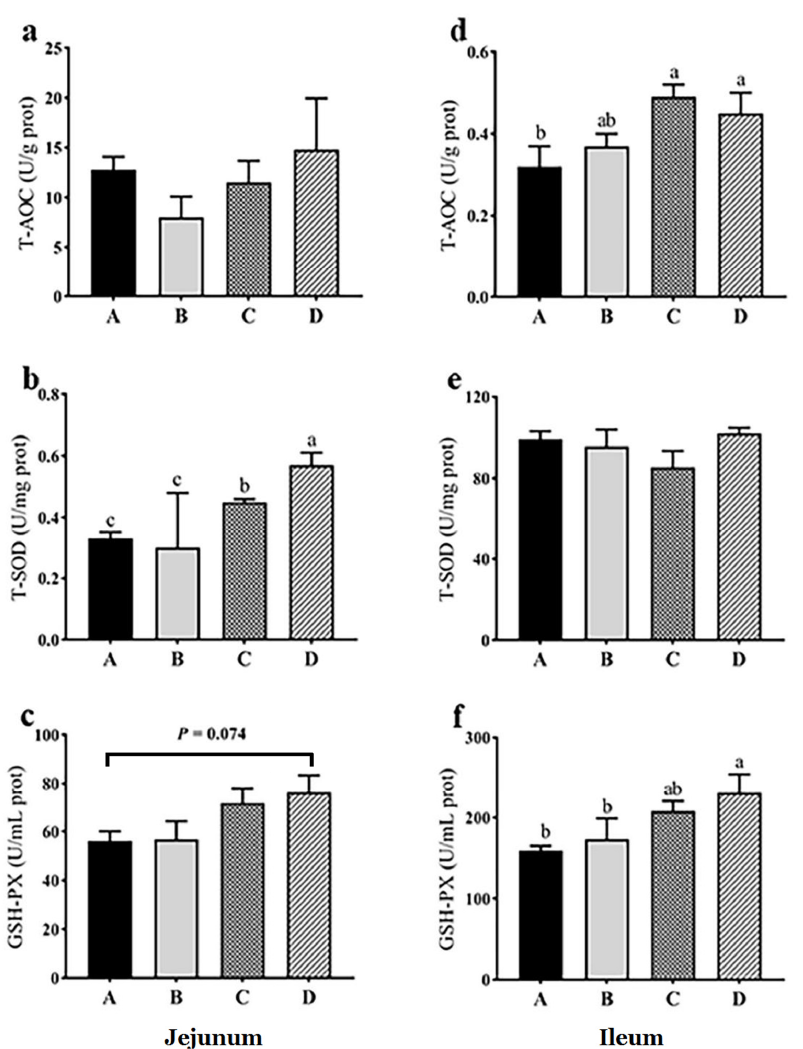
Figure 1. Effects of dietary probiotics on jejunal ( a – c ) and ileal ( d – f ) antioxidant capacities of geese at the age of 70 days. Note: a and d for total antioxidative capacity (T-AOC), b and e for total activity of superoxide dismutase (T-SOD), c and f for the activity of glutathione peroxidase (GSH-PX). Group A (as control) was fed a basal diet, the treatment groups (B, C and D) were fed the basal diet supplemented with 250 mg/kg Clostridium butyricum (viable count 3.0 × 10 6 CFU/g), 250 mg/kg Bacillus subtilis (viable count 2.0 × 10 7 CFU/g), or the combination of 250 mg/kg Clostridium butyricum plus 250 mg/kg Bacillus subtilis , respectively. n = 6. Different letters above the bars indicate significant differences between the groups ( p < 0.05). The data are presented as the mean ±